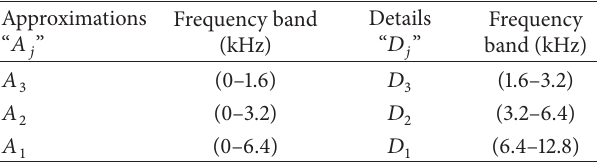
Table 2: DWT 3 level frequency bands.